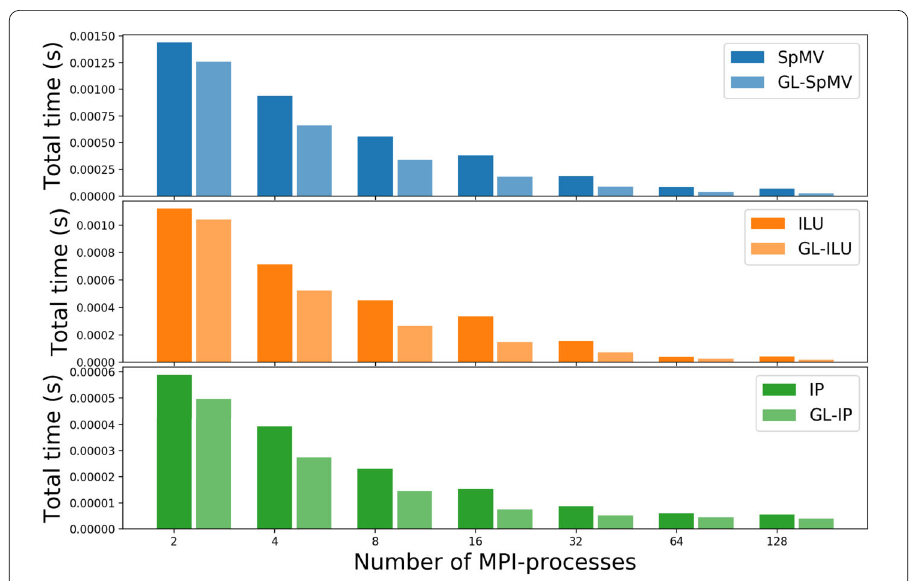
Figure 5 Time measurements (in seconds) of parallel linear algebra kernels for the Norne case, obtained on the Abel cluster, with and without the non-contributing computations. The GL prefix means the ghost-related non-contributing computations are